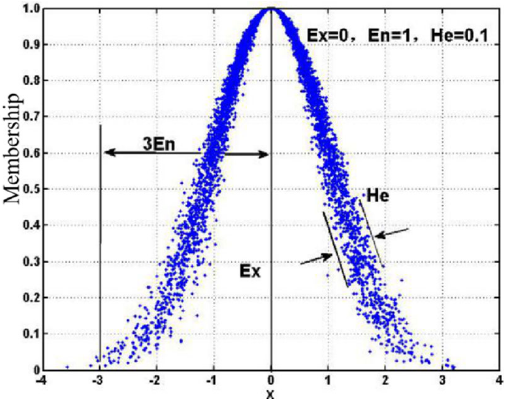
Figure 1. Normal cloud model with